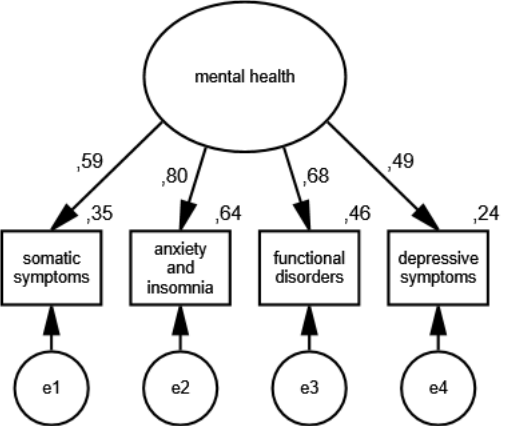
Figure 3. Standardized effects of the mental health disorder measurement model in the group of women .